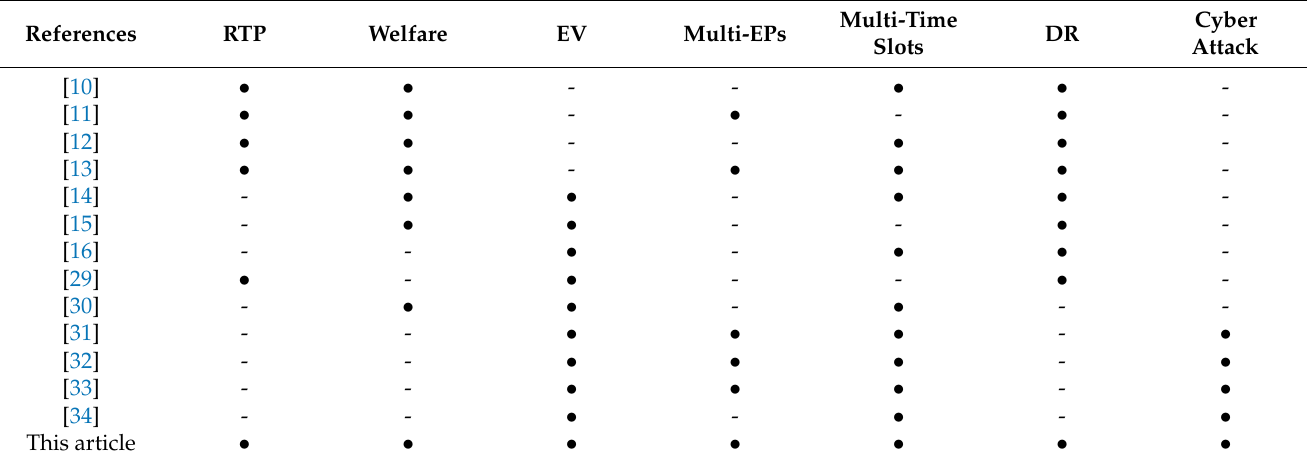
Table 1. Summary of some studies on the energy scheduling problems in